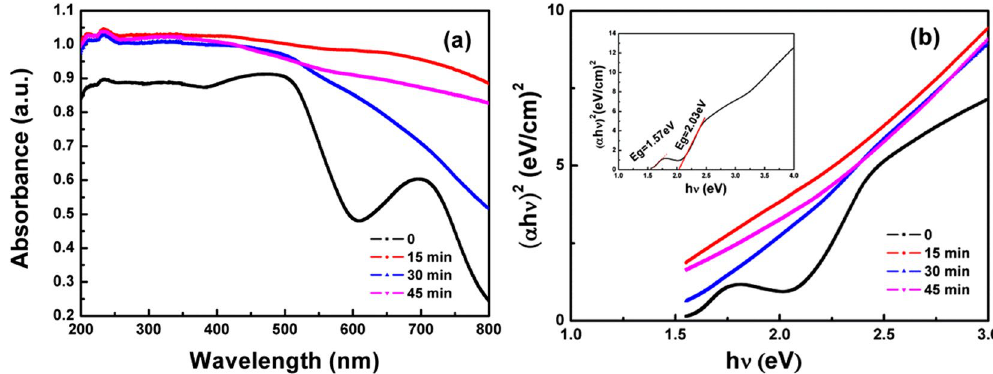
Figure 6. ( a ) UV-visible absorption spectra and ( b ) Degradation kinetics linear simulation curve in the presence of Bi 2 Fe 4 O 9 with different etching